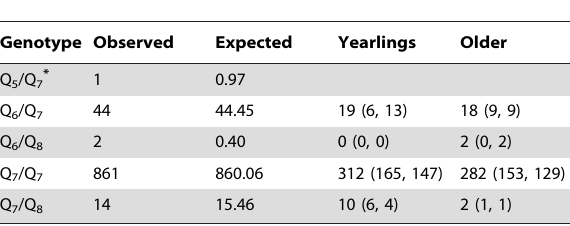
Table 2. Observed and expected (after Levene’s correction) genotype frequencies of the Clock gene for 922 adult barn swallows.